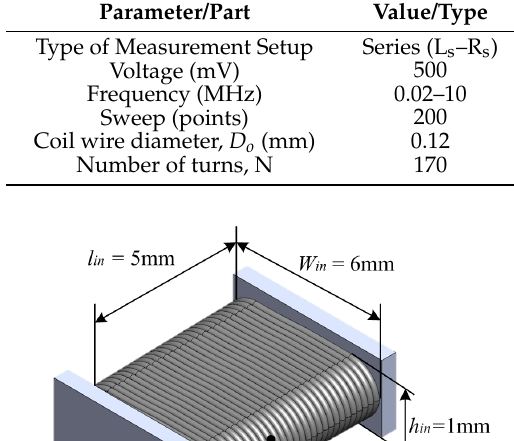
Table 1. Specifications for field testing experimental setup.